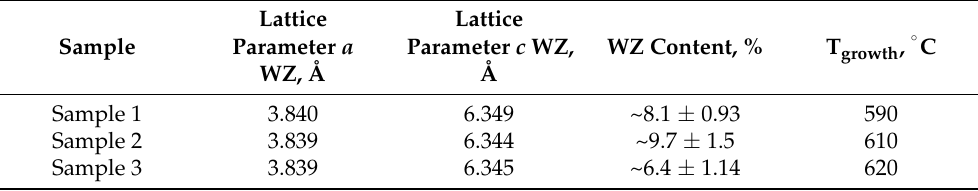
Table 1. Calculated crystal phase content in the investigated samples with the corresponding growth